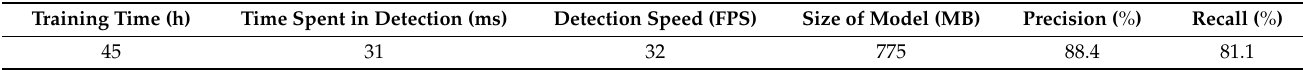
Table 6. Other indicators of improved